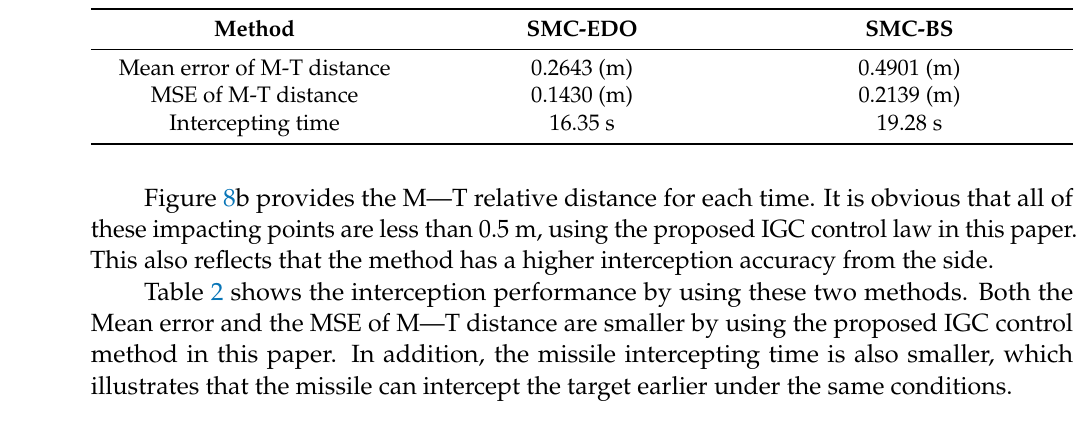
Figure 8. ( a ) The miss distance in x and y; ( b ) The characteristic of the relative distance of M—T. Table 2. The interception performance under case IV.